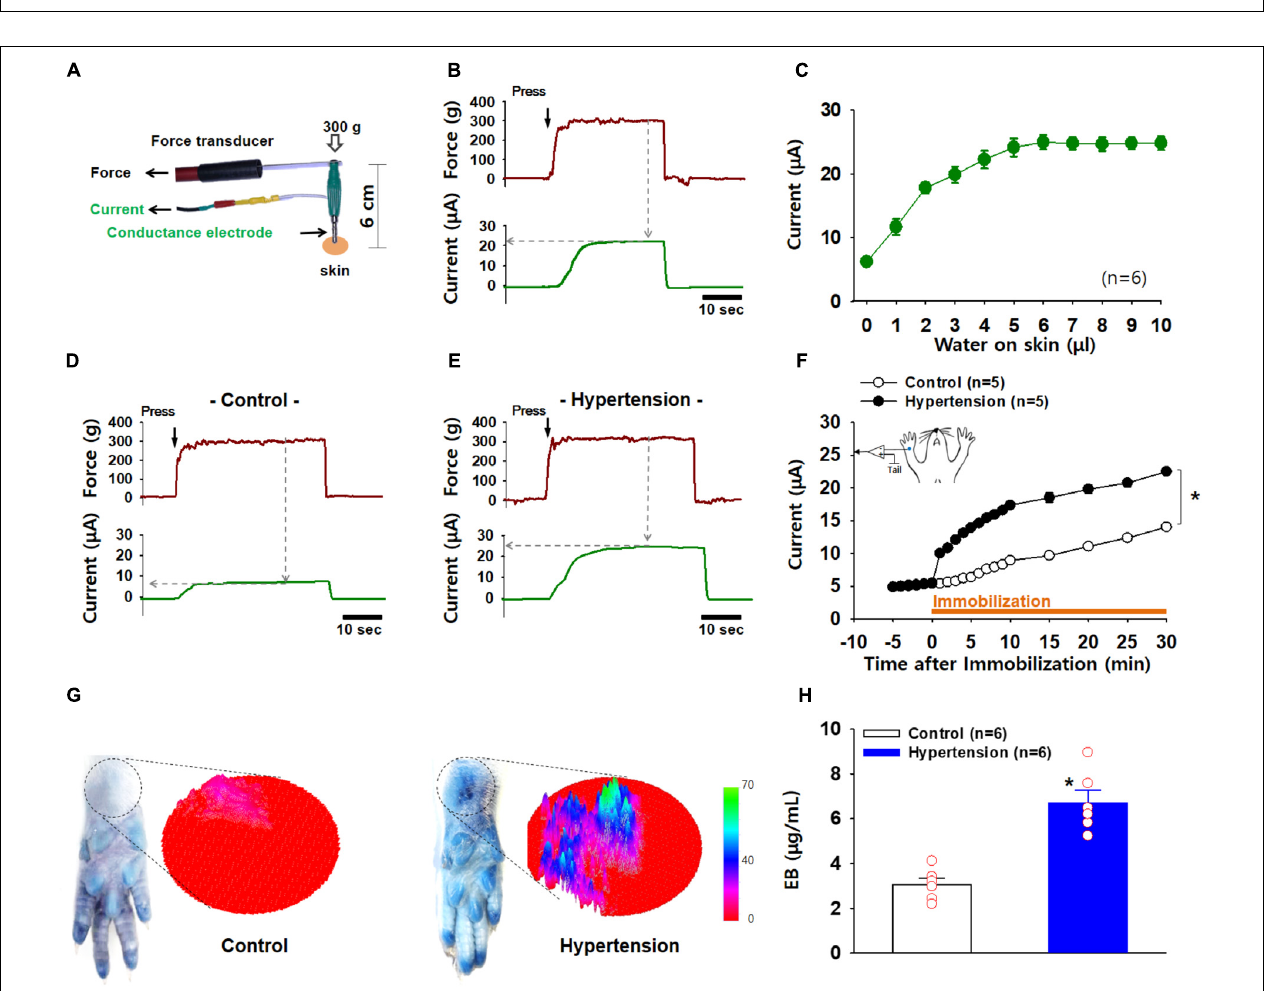
FIGURE 3 | Increased electrical conductance and plasma extravasation at acupoints in IMH rats. (A) A newly constructed electrode for the simultaneous measurement of conductance and applied pressure. (B) A representative trace of applied force and electrical currents. Conductance was estimated as the maximum current value ( µ A) reached when a pressure of 300 g on the electrode was held constant. (C) Changes in conductance induced by various amounts of water topically applied to rat skin. (D–F) Increased conductance at acupoints following IMH. A representative trace of applied pressure (upper panels) and electrical currents (low panels) recorded in wrist acupoints of control and IMH rats. Significantly increased conductance at the wrist acupoint was observed in IMH rats compared to that in control (F) . p < 0.05 vs. control. (G) Extravasation of EBD over the wrist acupoint of hypertensive rats. Representative photographs of wrist areas in control and IMH rats 2 h after intravenous injection of EBD and the 3D images created from the circles in the photographs by using ImageJ. (H) Concentration of EBD in the wrist acupoints of naïve control and IMH rats. ∗ p = 0.027 vs. control.